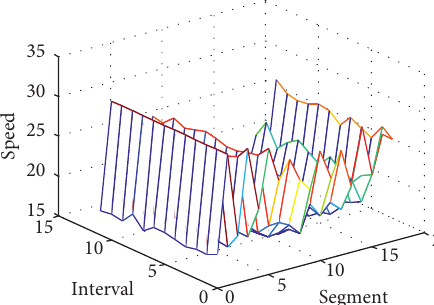
Figure 14: The speed distribution without VSL.